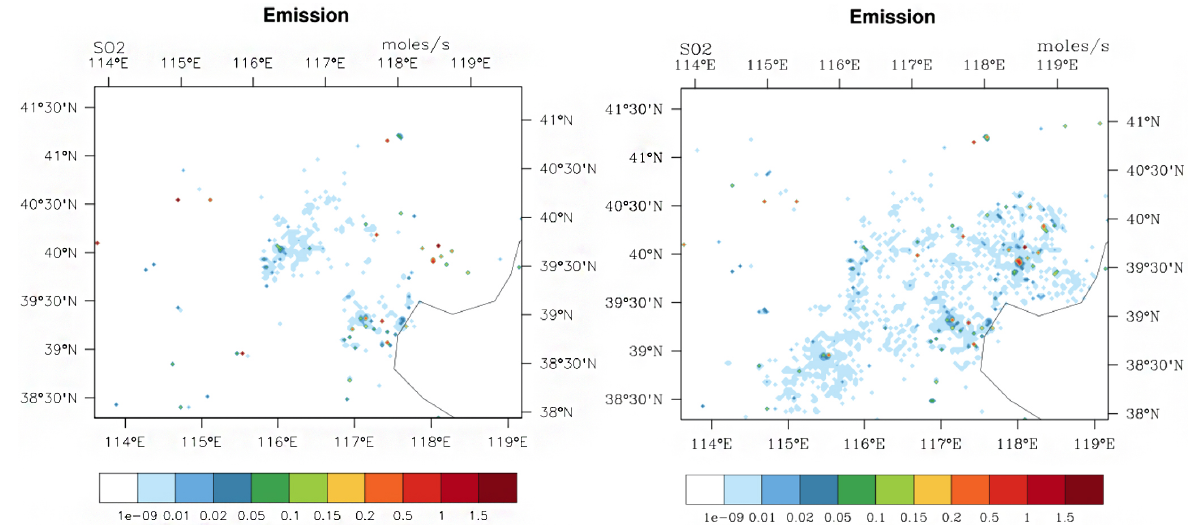
Figure 4. The point source emissions in the “new” D4 domain. Left: the point source emissions in the forecast system; right: the “new” simulation – more point source emissions in Tangshan, Baoding and Langfang have been added.